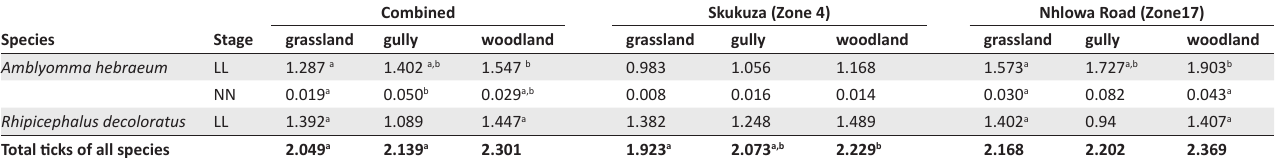
TABLE 2: Mean monthly tick collections [log 10 ( n + 1)] organised according to habitat.